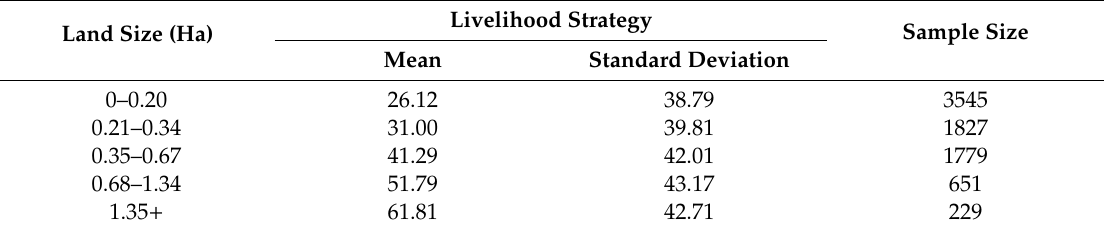
Table 3. Livelihood strategies of rural households with di ff erent land scales and their di ff erences. Land Size